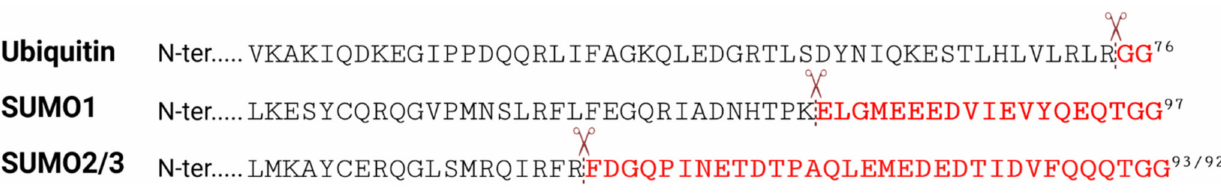
Figure 2. The C-terminal amino-acid sequences of ubiquitin and SUMO paralogs. Scissors indicate trypsin cleavage sites. Amino acid remnants that remain on UBL-modified peptides after tryptic digest are highlighted in